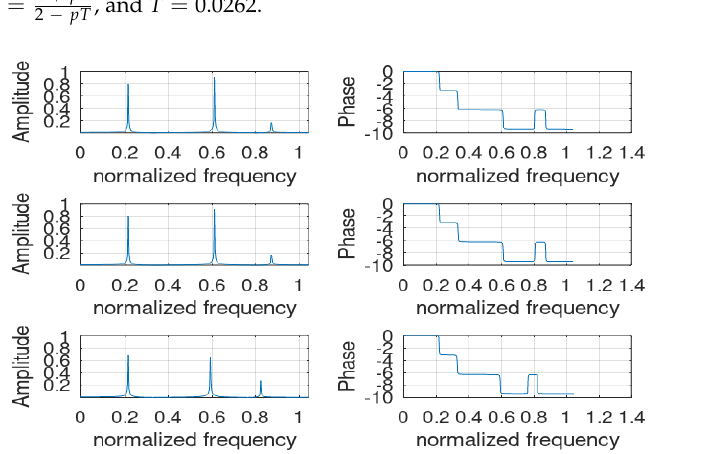
Figure 5. Comparison of original (upper) and transformed frequency responses with θ = e pT , + pT ζ = 2 , and T = 2 − pT